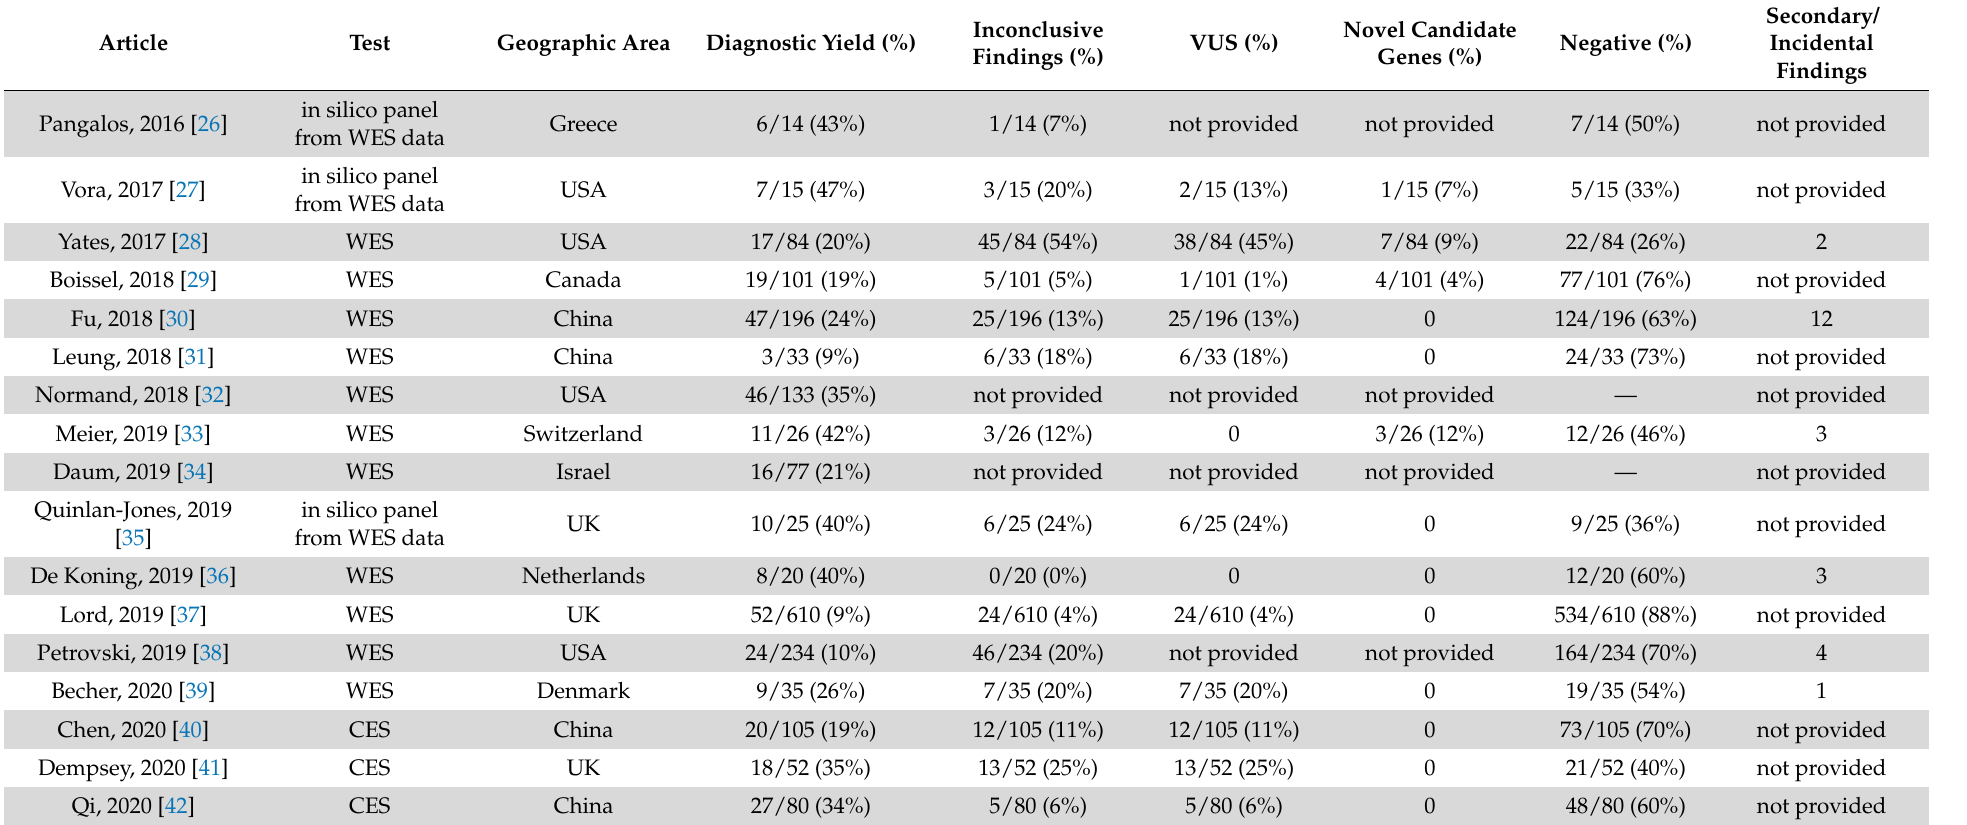
Table 1. pES in fetuses selected for US anomalies (regardless of the affected